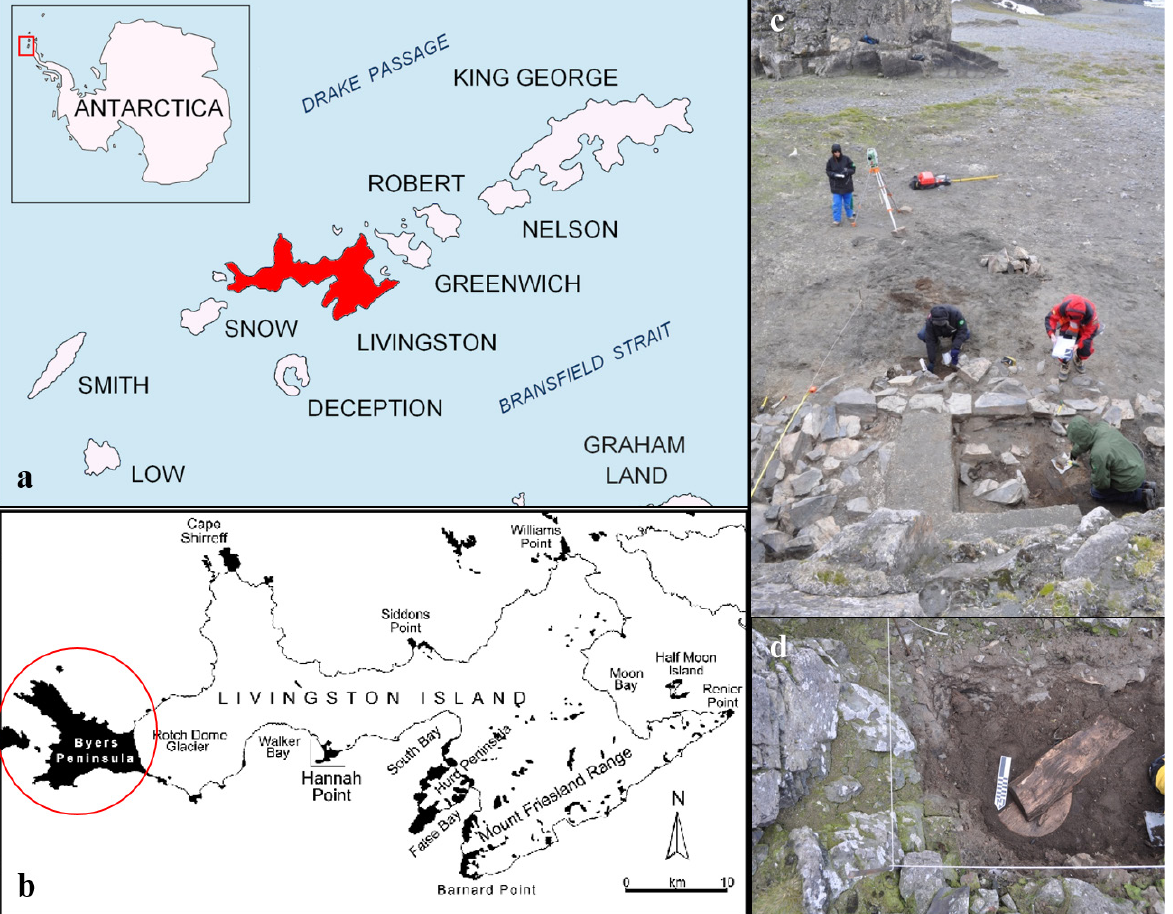
Figure 1. Location where the archaeological artifacts were sampled. ( a ) Antarctic Peninsula, ( b ) Livingston Island, and Byers Peninsula (inside the red circle). ( c, d ) Examples of archaeological sites where the artefacts were sampled. Photos ( c ) belong to A.